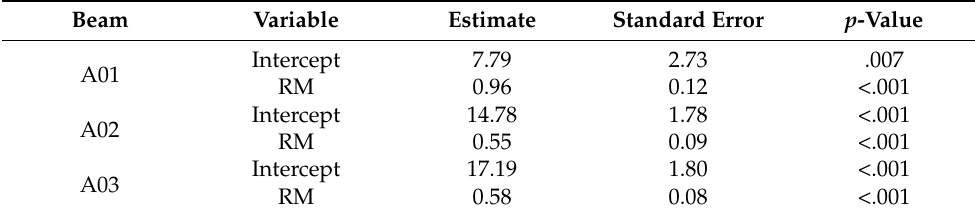
Table 10. Estimates for regression models of FF vs. RM for different beams.